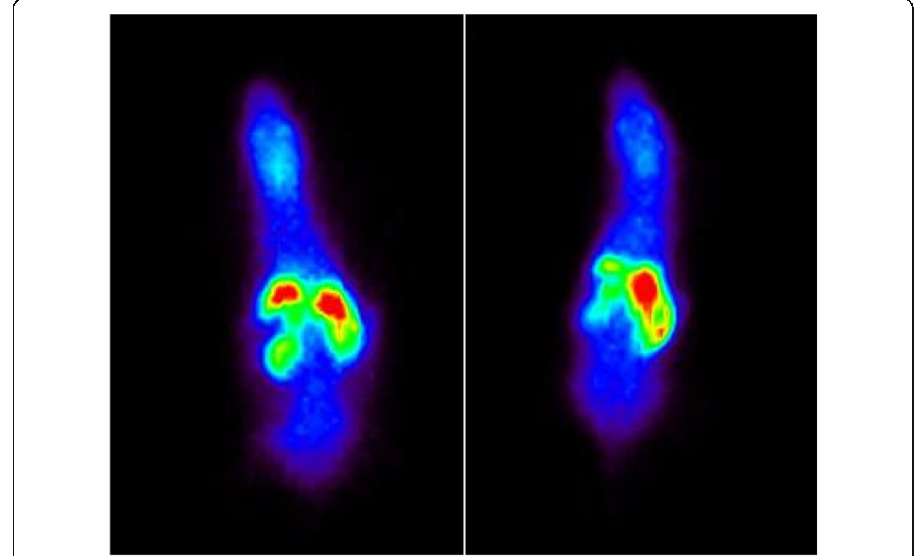
Fig. 8 Summed PET image (2 – 20 min) of [ 18 F] 5 in a wild-type mouse (left) and a P-gp KO mouse